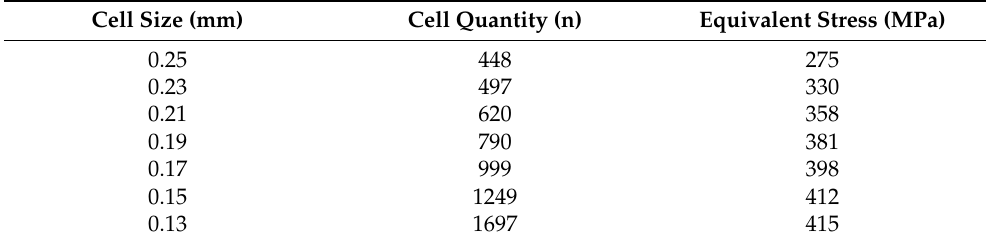
Table 2. Gridding and equivalent